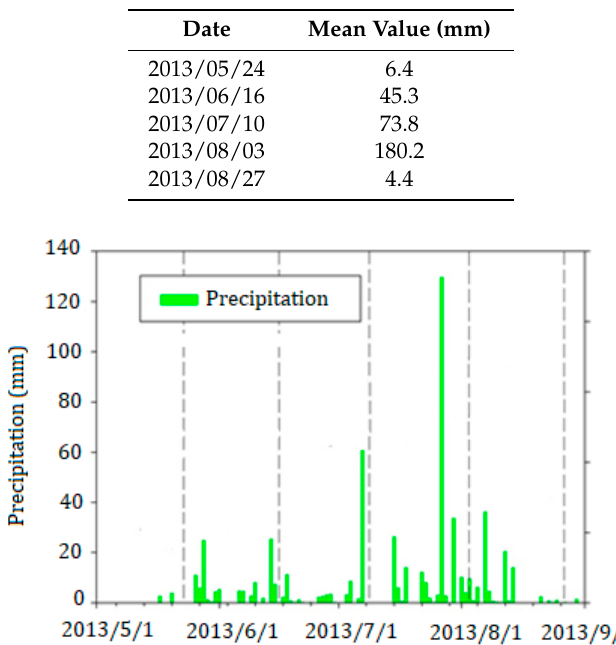
Figure 3. Daily precipitation (from 13 May 2014 to 30 August 2014). The five vertical dashed lines indicate synthetic aperture radar (SAR) observation dates (23 May, 16 June, 10 July, 3 August, and 27 August).